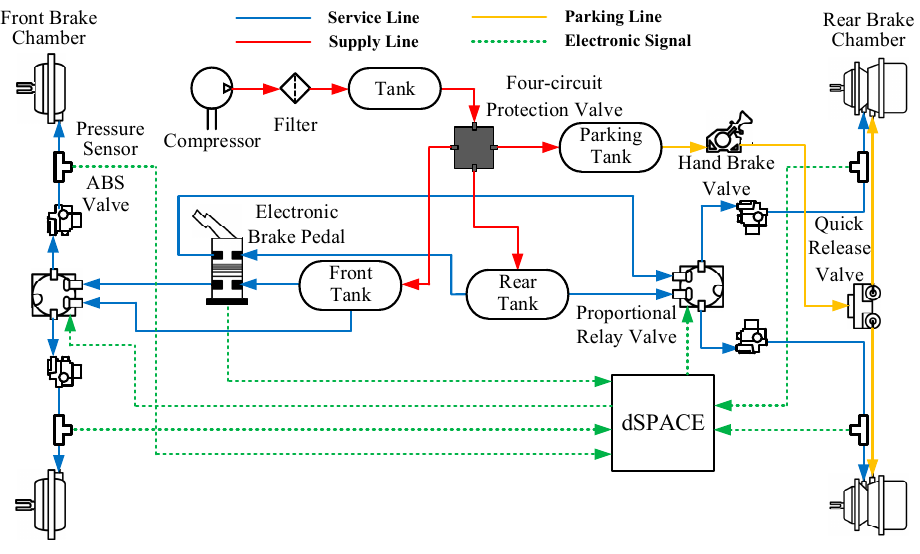
Figure 3. Structure of passenger car’s pneumatic braking system.